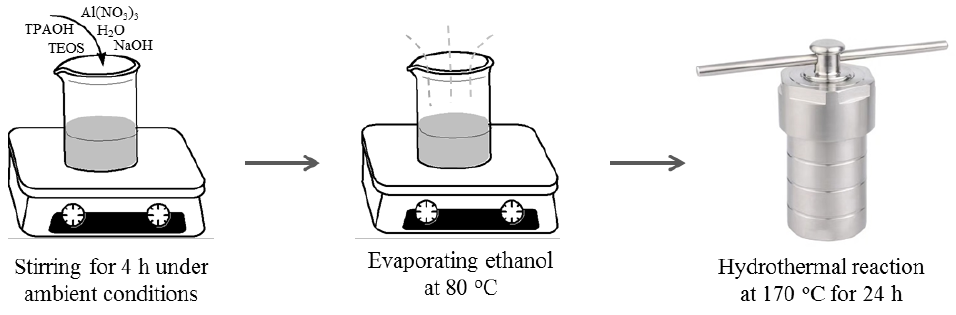
Figure 11. Schematic diagram of ZSM-5 zeolite synthesis.